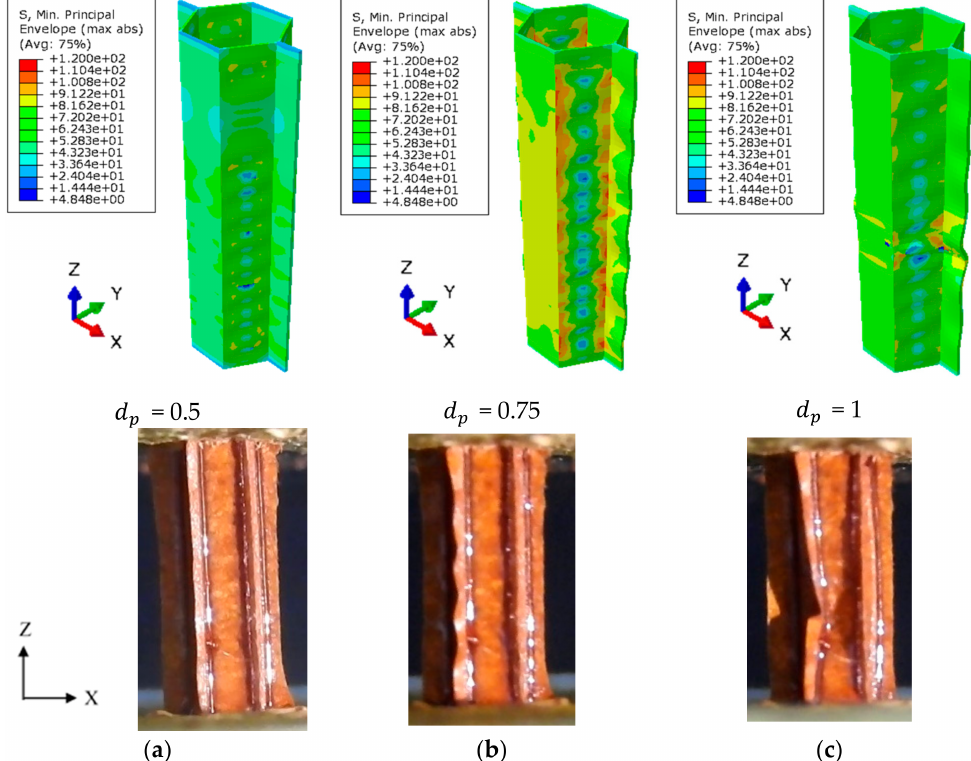
Figure 13. Distribution of the (compressive) minimum principal stress (top) and the deformation (bottom) during the out-of-plane compression test of the one-cell specimen. ( a ) Matrix damage, d p = 0, following damage initiation; ( b ) d p = 0.75, showing wrinkling of the unconstrained cell walls; and ( c ) d p = 1.0, with the occurrence of the first